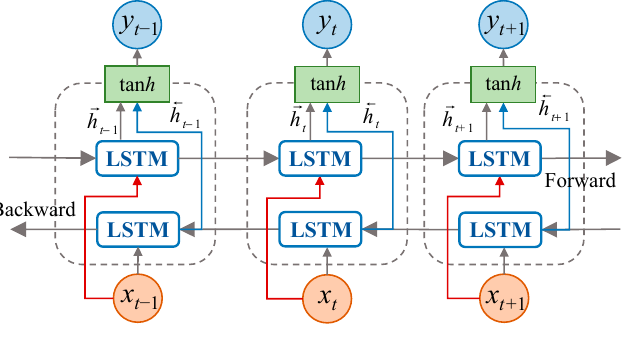
Figure 3. The structure of Bi-LSTM.